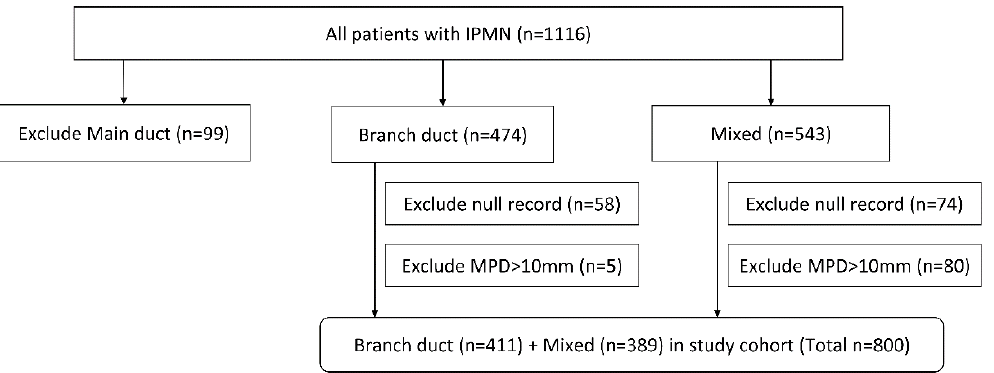
Figure 1. Flow diagram of the analysis by type of IPMN. IPMN, intraductal papillary mucinous neoplasm; MPD, main pancreatic duct.